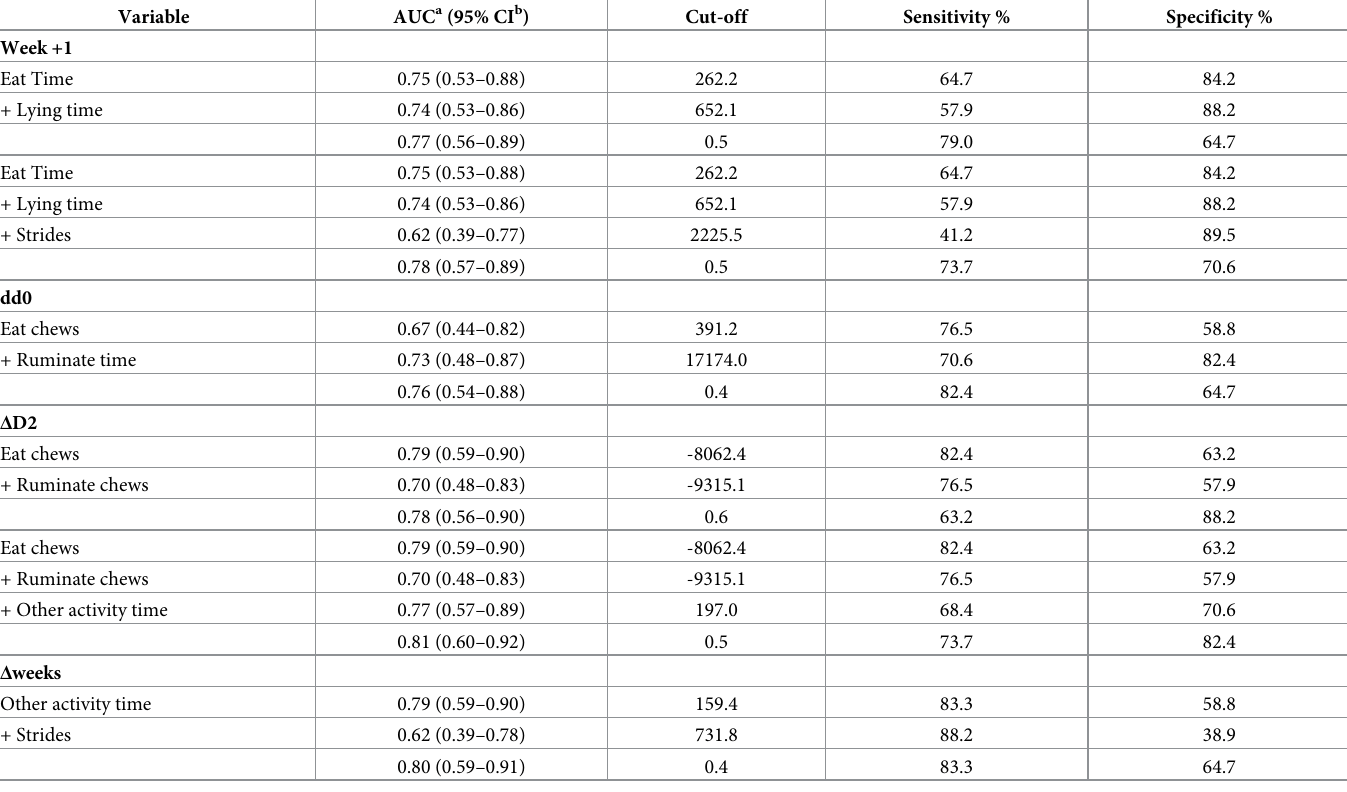
Table 7. Combination of the different Rumiwatch 1 noseband sensor and pedometer variables as predictors of cows being sick in multivariable logistic regression and receiver characteristics analysis on different cut-off values with corresponding sensitivity and specificity.